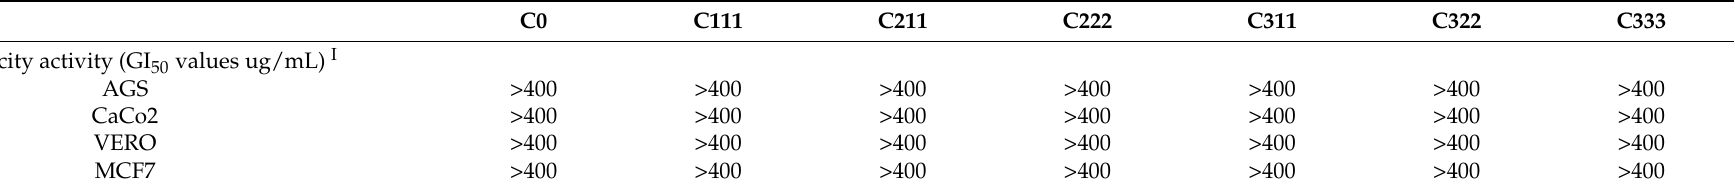
Table 7. Cont. C0 Cytotoxicity activity (GI 50 values ug/mL) I AGS CaCo2 VERO Means in the same row followed by different Latin letters are significantly different at p < 0.05, according to Tukey’s HSD test. A. Trolox IC 50 values: 5.8 ± 0.6 µ g/mL (TBARS), 21.8 ± 0.3 µ g/mL (OxHLIA 60 min); B Ketoconazole MIC/MFC (mg/mL): ( A. brasiliensis 0.06/ 0.125, A. fumigatus 0.5/1), C Ampicillin for clinical bacteria tested at a maximum of